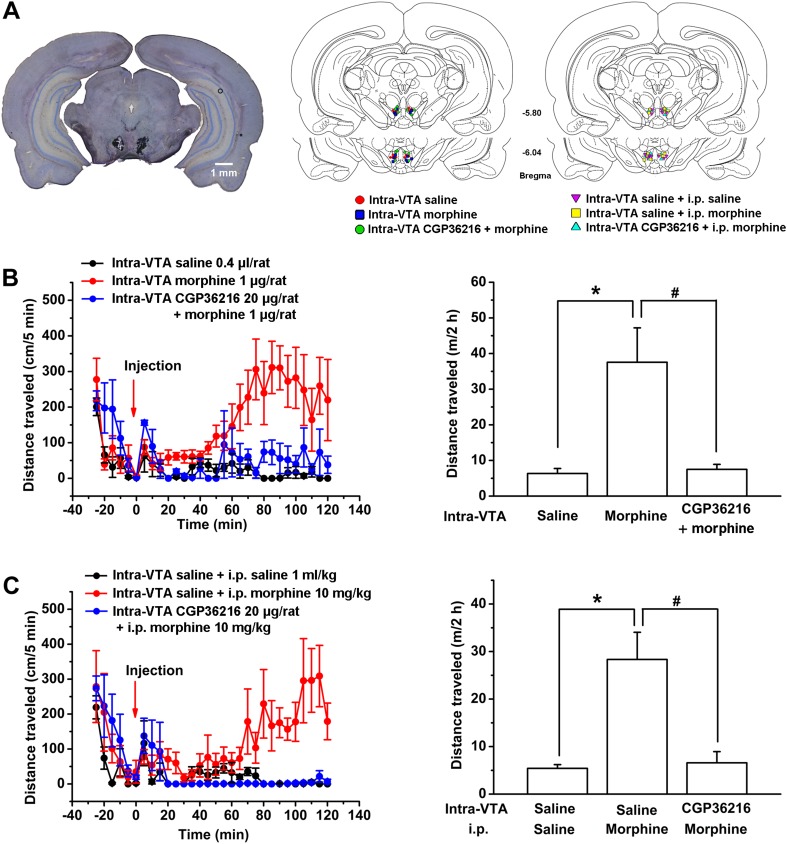
Influence of intra-ventral tegmental area (VTA) injection of the presynaptic GABAB receptor antagonist CGP36216 on morphine-induced increase in locomotor activity in rats.(A) Injection sites were verified under light microscope. Left panel: Representative Nissl-stained photomicrograph of cannula tracts terminating in the VTA. Right panel: location of the injection cannula tips in the VTA of rats used in data analyses. Numbers indicate coordinates relative to bregma. (B) Influence of intra-VTA injection of the presynaptic GABAB receptor antagonist CGP36216 on intra-VTA injection of morphine inducing an increase in locomotor activity. Left panel: time course of locomotor activity before and after intra-VTA injection of saline or morphine (1 μg/rat), or morphine (1 μg/rat) with CGP36216 (20 µg/rat) (n = 6 rats). Right panel: average distance traveled by rats during 120 min after treatment with an intra-VTA injection of saline or morphine (1 μg/rat), or morphine (1 μg/rat) with CGP36216 (20 µg/rat) (n = 6 rats; *p < 0.05, compared with intra-VTA injection of saline, #p < 0.05, compared with intra-VTA injection of morphine. (C) Influence of intra-VTA injection of the presynaptic GABAB receptor antagonist CGP36216 on intraperitoneal (i.p.) morphine-induced increase in locomotor activity. Left panel: time course of locomotor activity before and after intra-VTA injection of saline co-administered with either i.p. saline (1 ml/kg) or morphine (10 mg/kg), and i.p. morphine (10 mg/kg) with intra-VTA injection of CGP36216 (20 μg/rat) (n = 6 rats). Right panel: average distance traveled by rats during 120 min after treatment with intra-VTA injection of saline co-administered with either i.p. saline (1 ml/kg) or morphine (10 mg/kg), and i.p. morphine (10 mg/kg) with intra-VTA injection of CGP36216 (20 μg/rat) (n = 6; *p < 0.05, compared with intra-VTA injection of saline co-administered with i.p. saline, #p < 0.05, compared with intra-VTA injection of saline co-administered with i.p. morphine). Data are shown as the mean ±s.e.m.